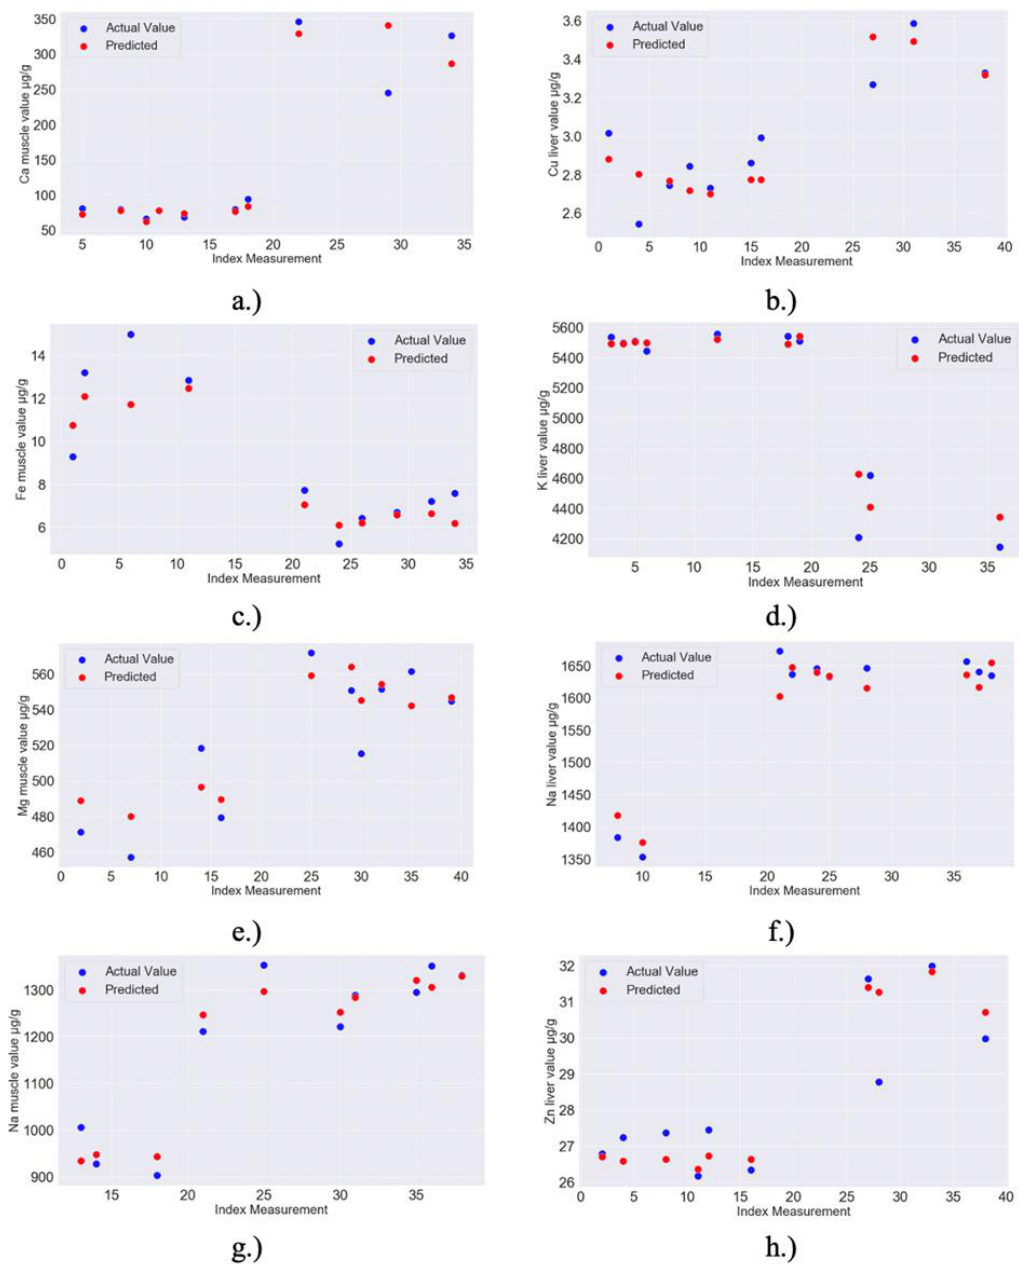
Figure A1. Prediction of heavy metal concentration for turbot liver and muscle tissues—actual values vs. predicted value of RF models for the first group MLR models, described in Section 2.2.1. (models 1–8b) (( a ). prediction for Ca concentration in muscle; ( b ). prediction for Cu concentration in liver; ( c ). prediction for Fe concentration in muscle; ( d ). prediction for K concentration in liver; ( e ). prediction for Mg concentration in muscle; ( f ). prediction for Na concentration in liver; ( g ). prediction for Na concentration in muscle; ( h ). prediction for Zn concentration in liver).